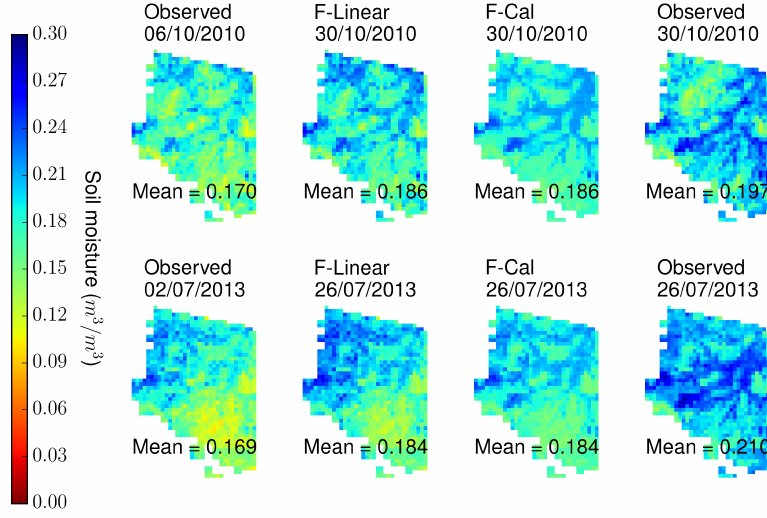
Figure 21. Comparison of the spatial distribution for the observed and MAPSM soil moisture at a spatial resolution of 500 m for the F-Cal and F-Linear experiments. Observed spatial distribution on 6 October 2010 is used to retrieve the soil moisture for 30 October 2010 and 2 July 2013 is used for the 26 July